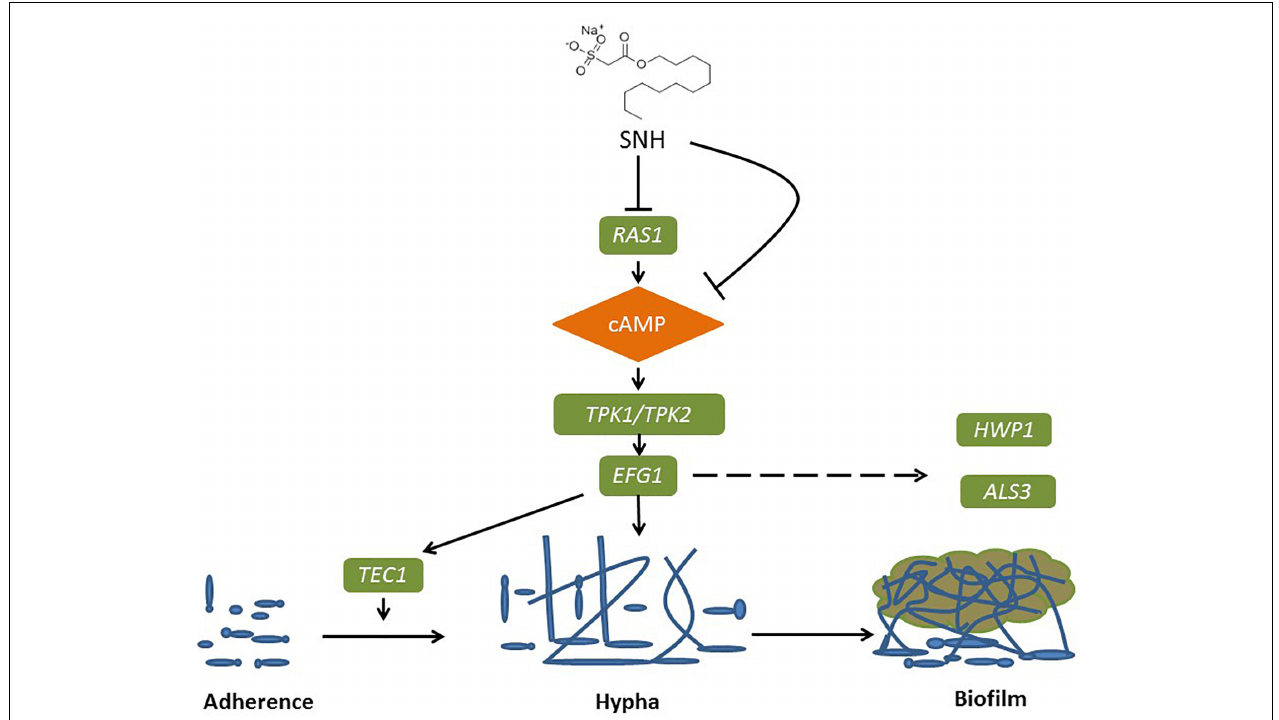
FIGURE 8 | Possible mechanism of SNH inhibits the biofilm formation of C. albicans by repression of Ras1-cAMP-Efg1